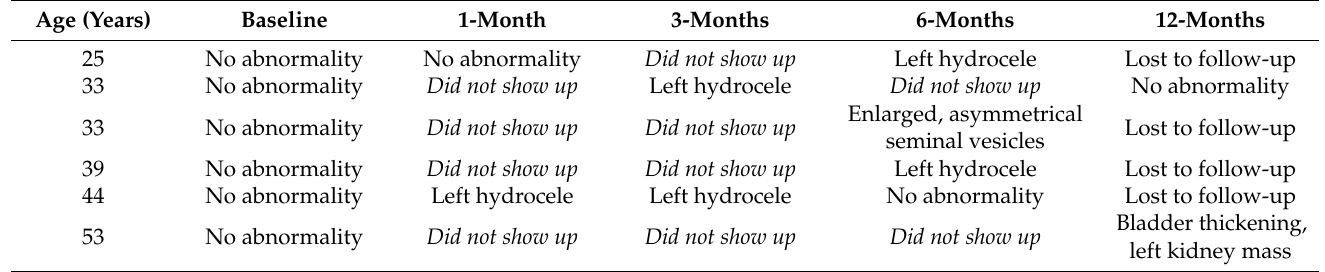
Table A2. Six participants with abnormalities in GU organs on ultrasonography during follow-up time-points but none at baseline in the study.